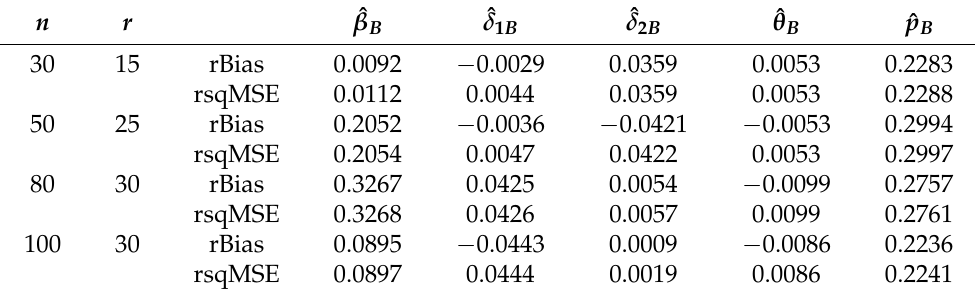
Table 4. The rBias and rsqMSE of Bayes estimates for p = 0.3.